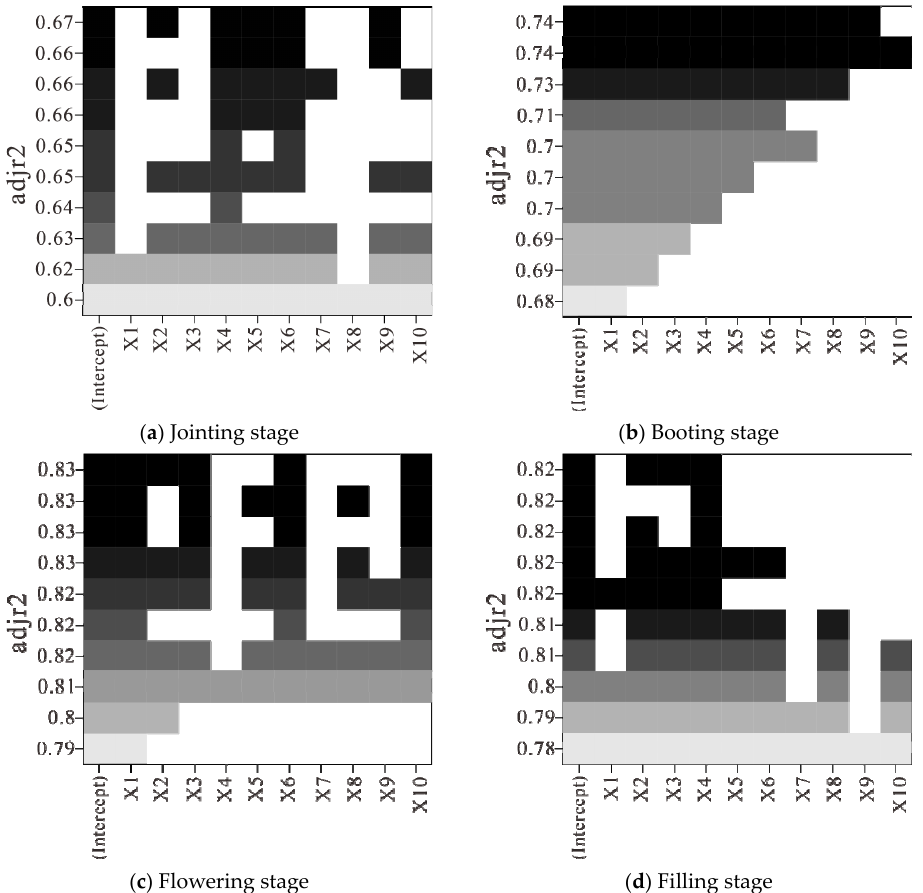
Figure 5. Optimal subset analysis of selected fractional differentiation spectrum for estimating